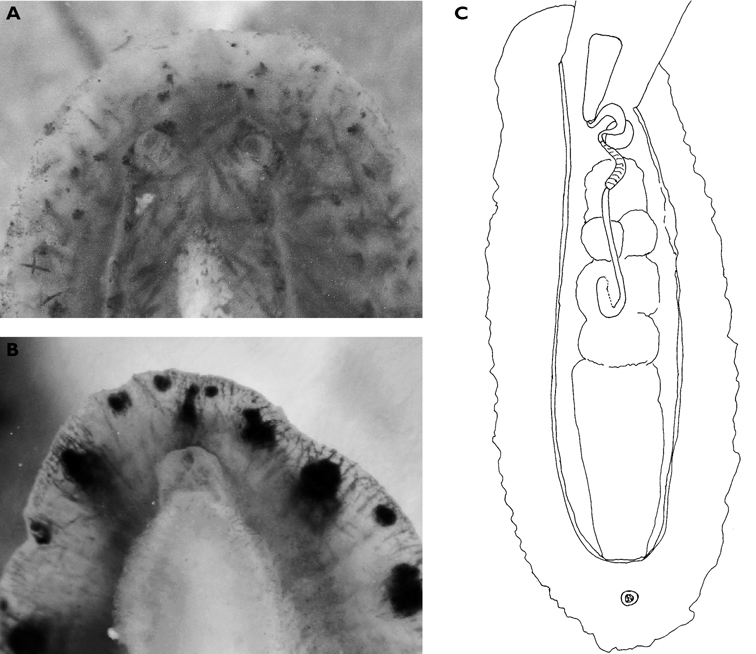
Phyllidiopsis sphingis
A dorsal view of rhinophores and spicule alignment of 19 mm specimen B ventral view of 17 mm specimen showing the large fused oral tentacles C digestive anatomy of 19 mm specimen.